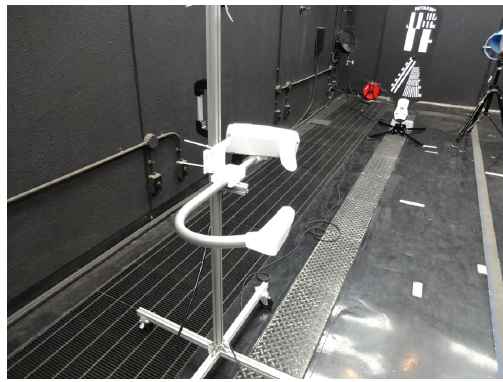
Figure 5. Forward scatter visibility sensor, Vaisala Present Weather Detector